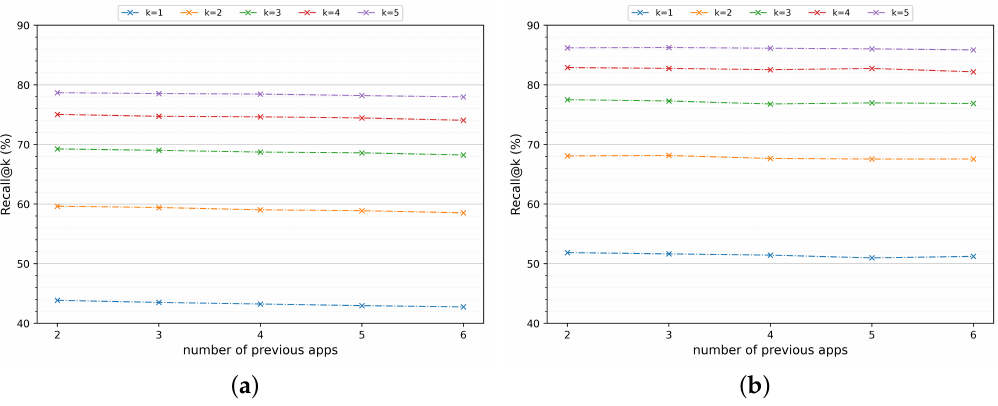
Figure 6. Recall@k performance average ( a ) and best month performance ( b ) for all users.